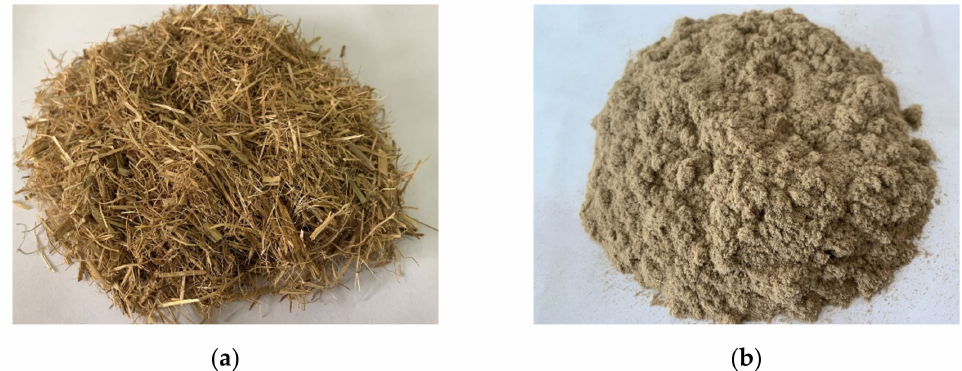
Figure 10. Rice straw fiber crushing before and after comparison. ( a ) Rice straw before crushing. ( b ) Rice straw fiber after crushing.